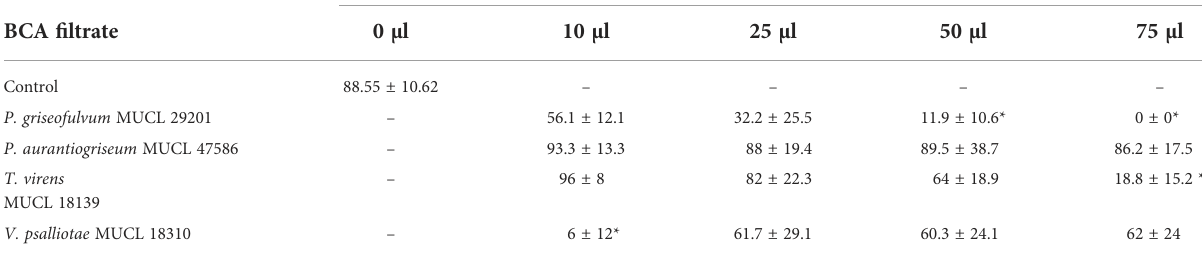
TABLE 2 Percentage of mycorrhizal plants (%MP) inoculated with alginate beads containing propagules of R. irregularis MUCL 41833 alone (control) or with different concentrations of culture fi ltrates of the fungal BCA